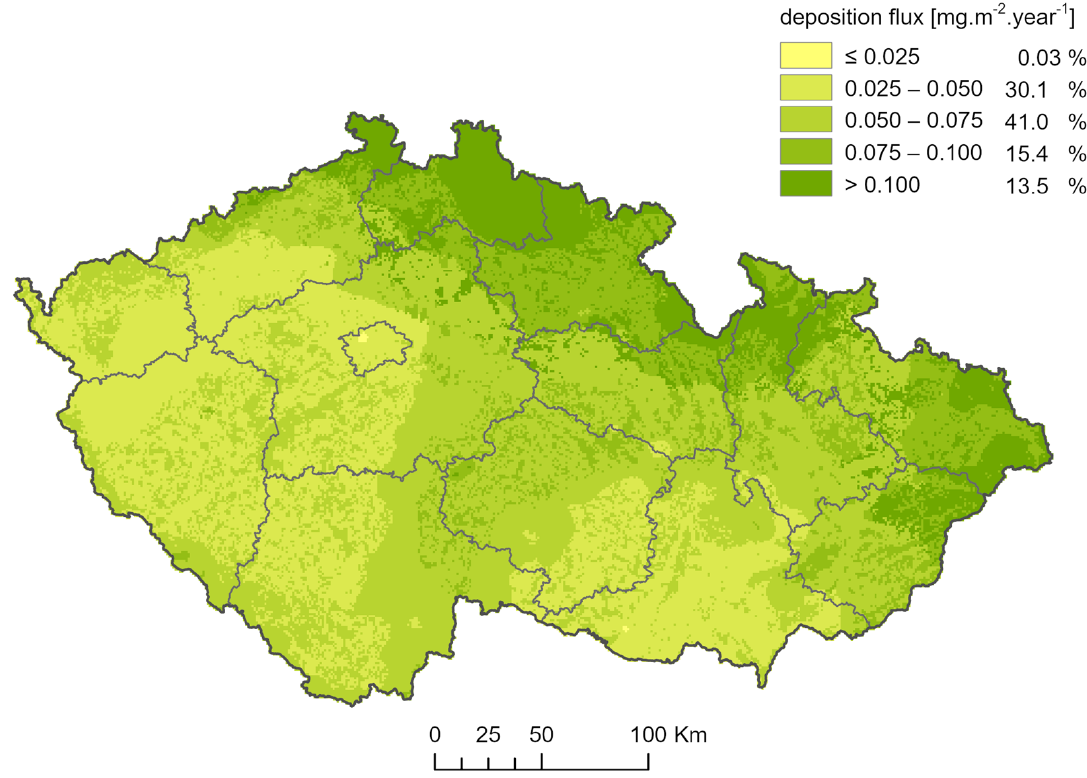
Figure 9. Spatial pattern of total Cd deposition, 2012.